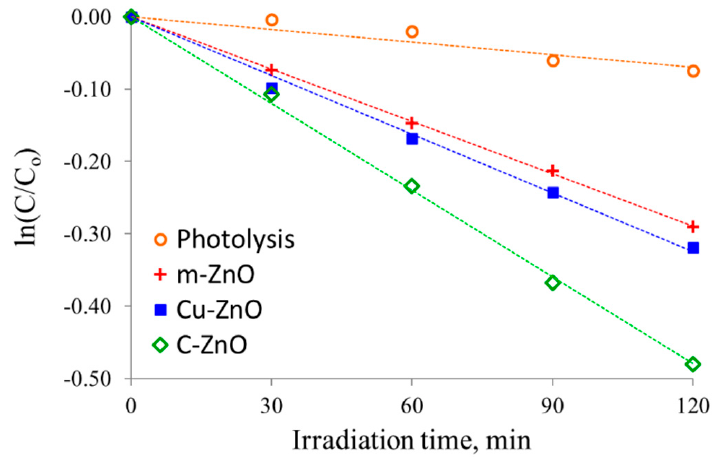
Figure 5. Efficiency of photocatalytic bleaching of aqueous MB solution under visible light irradiation using different photocatalyst films. The tests were performed in a high wall petri dish (40 mm diameter, borosilicate glass) with 7.5 mL of MB solution (initial concentration 10 mg/L). The intensity of the visible light irradiation at MB solution surface was approximately 40 mW/cm 2 .